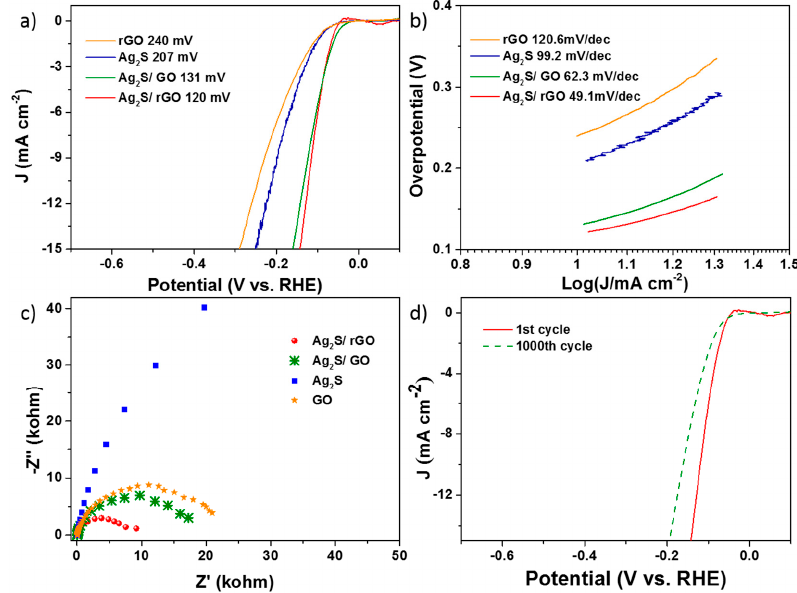
Figure 3. Electrocatalytic hydrogen evolution reaction (HER) performance. ( a ) Polarization curves recorded at a scanning speed of 20 mV/dec for Ag 2 S/rGO, Ag 2 S/GO, Ag 2 S, and rGO. ( b ) The corresponding Tafel curves of the catalysts derived from ( a , c ) Potentiostatic electrochemical impedance spectroscopy (PEIS) Nyquist plots acquired at the overpotentials of Ag 2 S/rGO, Ag 2 S/GO, Ag 2 S, and rGO obtained in ( a , d ) durability tests of Ag 2 S/rGO composite. Polarization curves were recorded before and after 1000 potential cycles in 0.5 M H 2 SO 4 aqueous solution, from − 2 to +2 V (vs. reversible hydrogen electrode (RHE)). Table 1. Characteristics of Ag 2 S/rGO for the HER. Samples